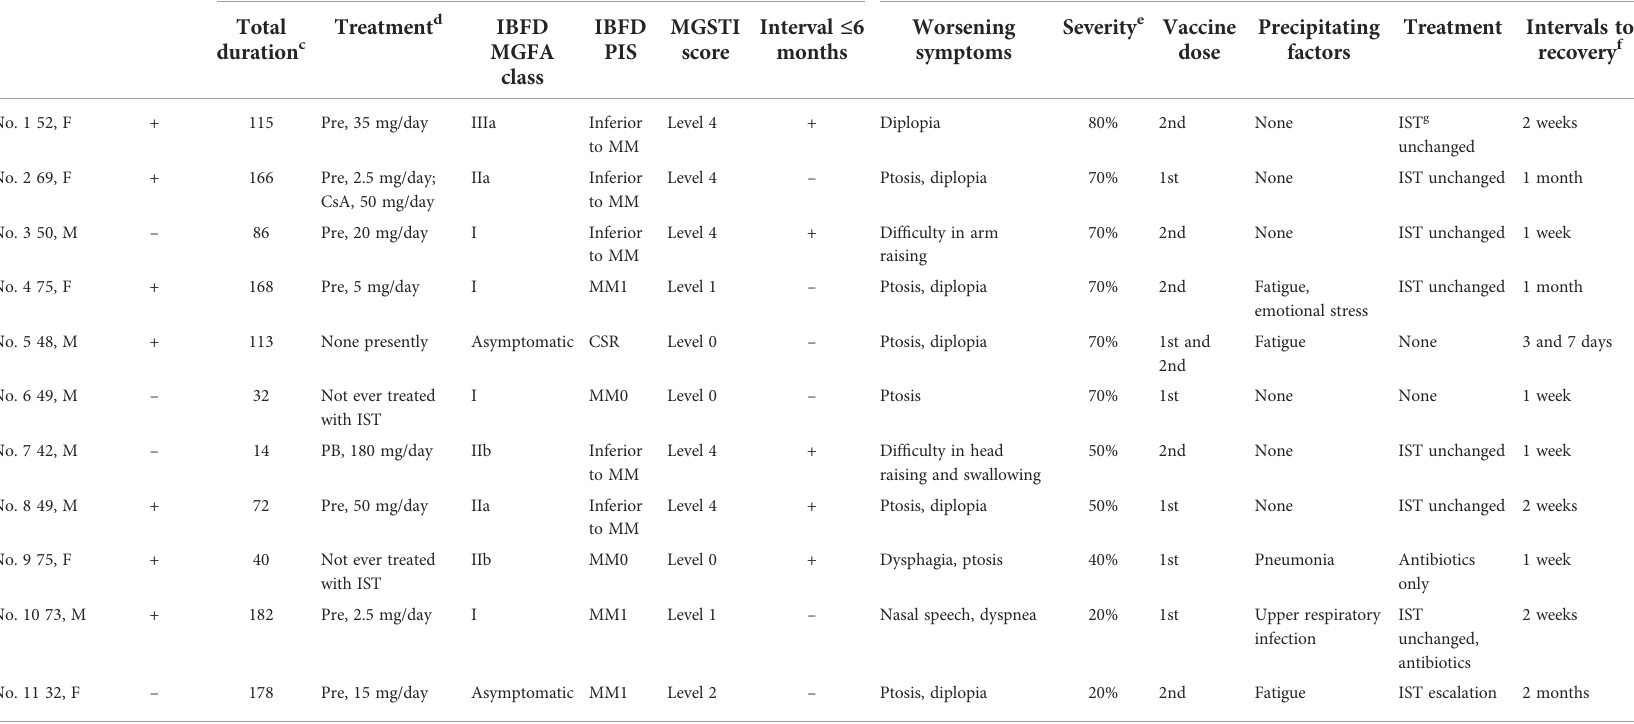
TABLE 2 Details on the 11 patients with